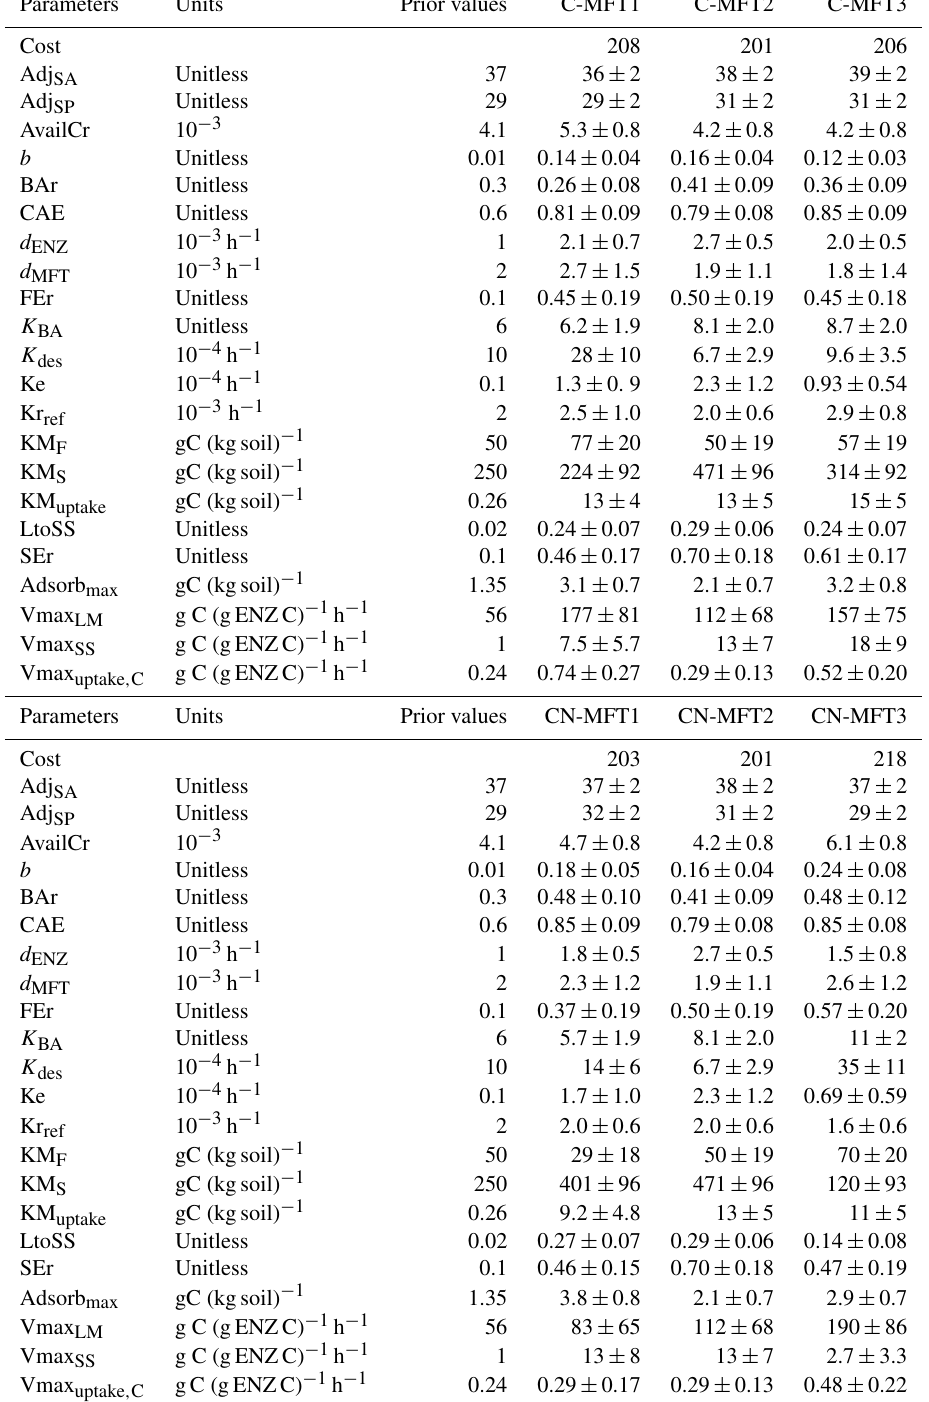
Table 7. Optimized values and uncertainties of parameters for the six variants of the ORCHIMIC model.